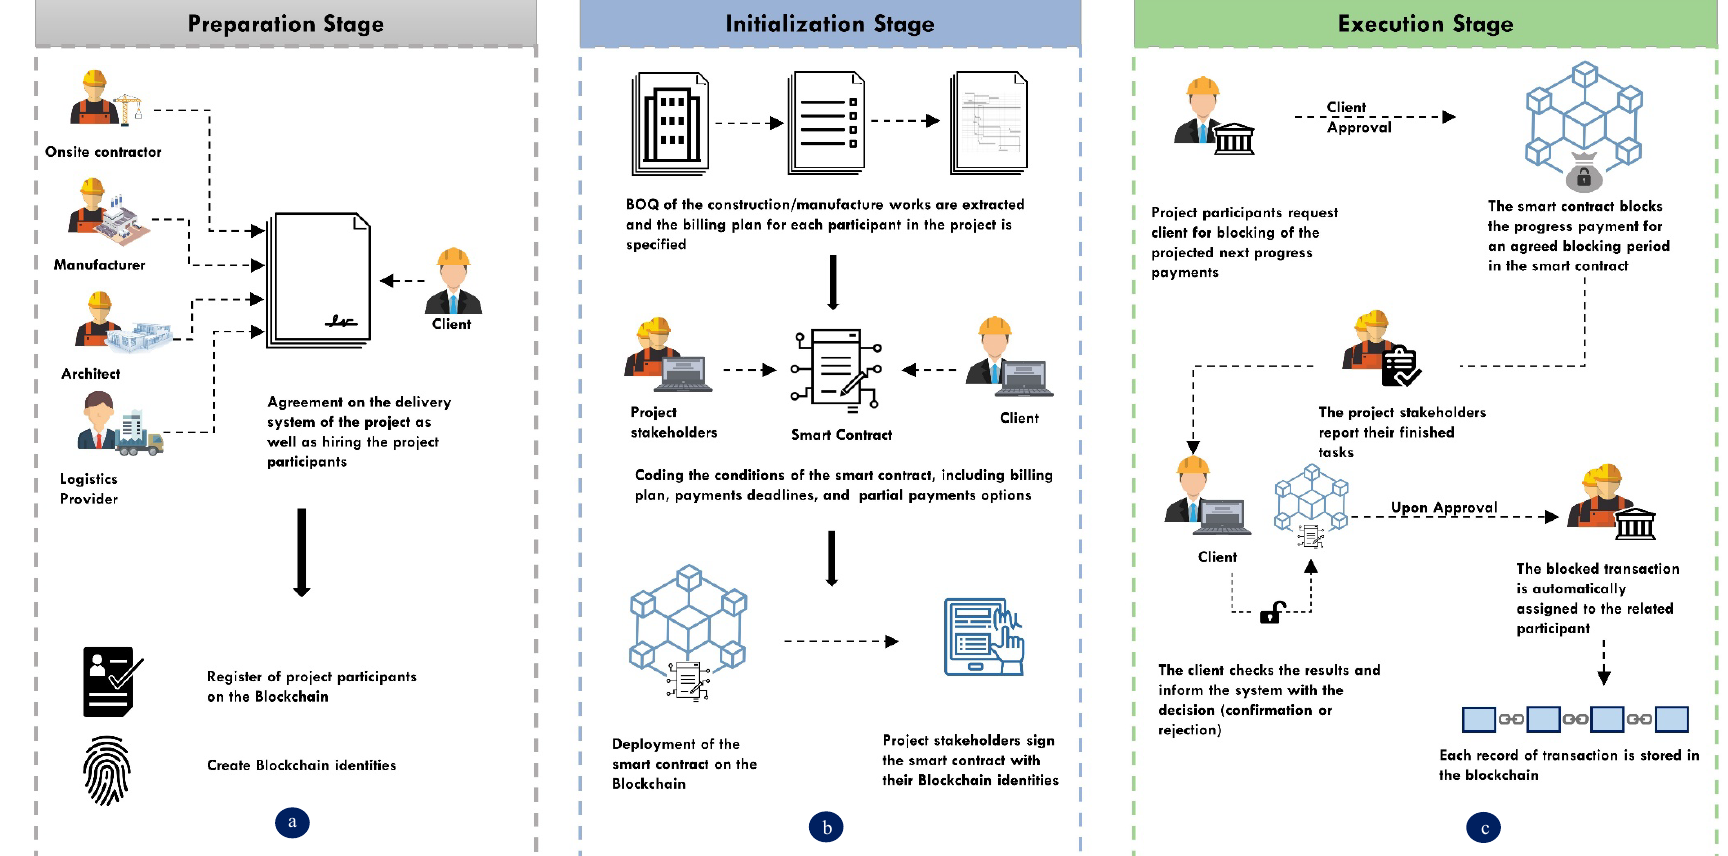
Figure 12. Conceptual framework for automating payments among project stakeholders in modular integrated construction.